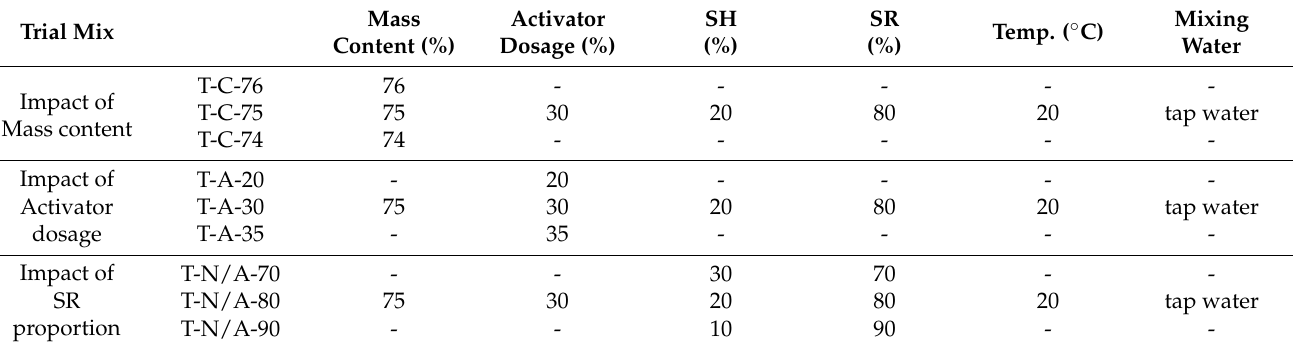
Table 3. Summary of the mix compositions of the CPB specimens